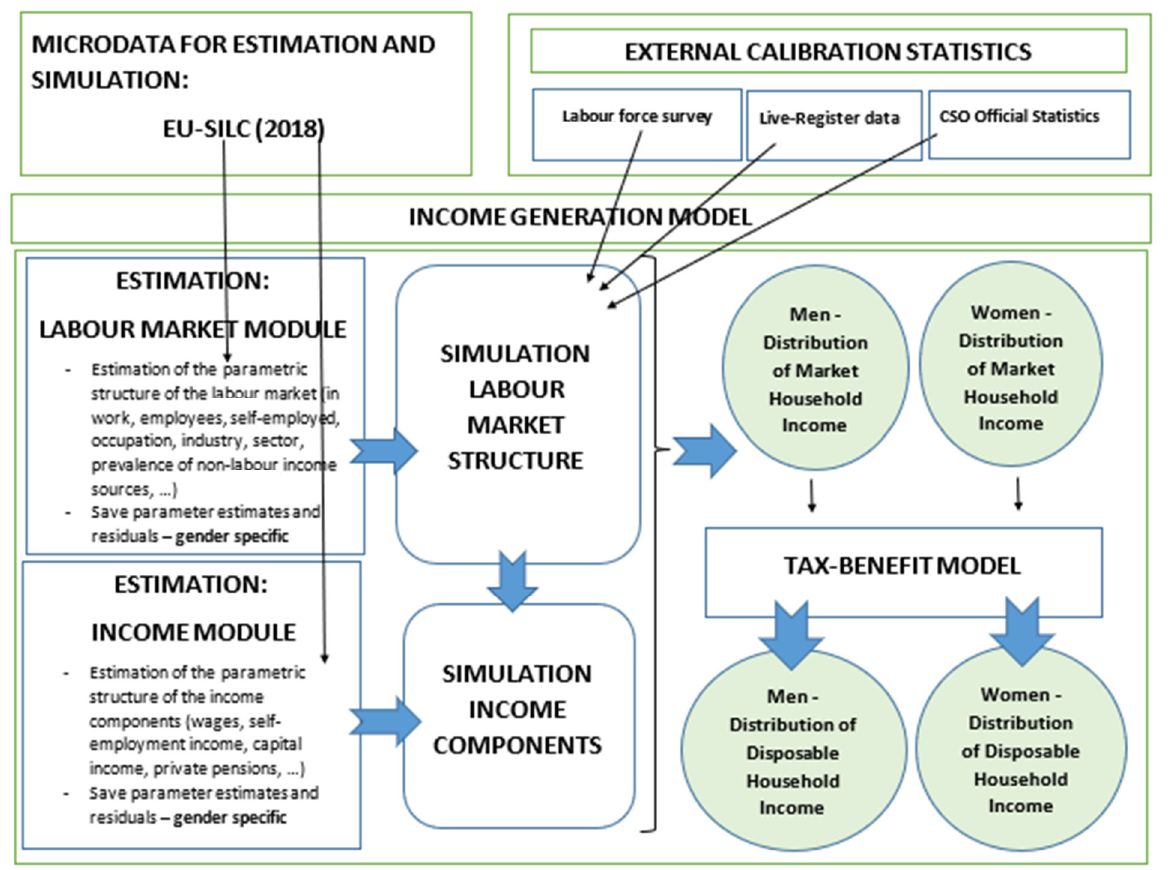
Figure 4. Model Figure 4. Model Structure.